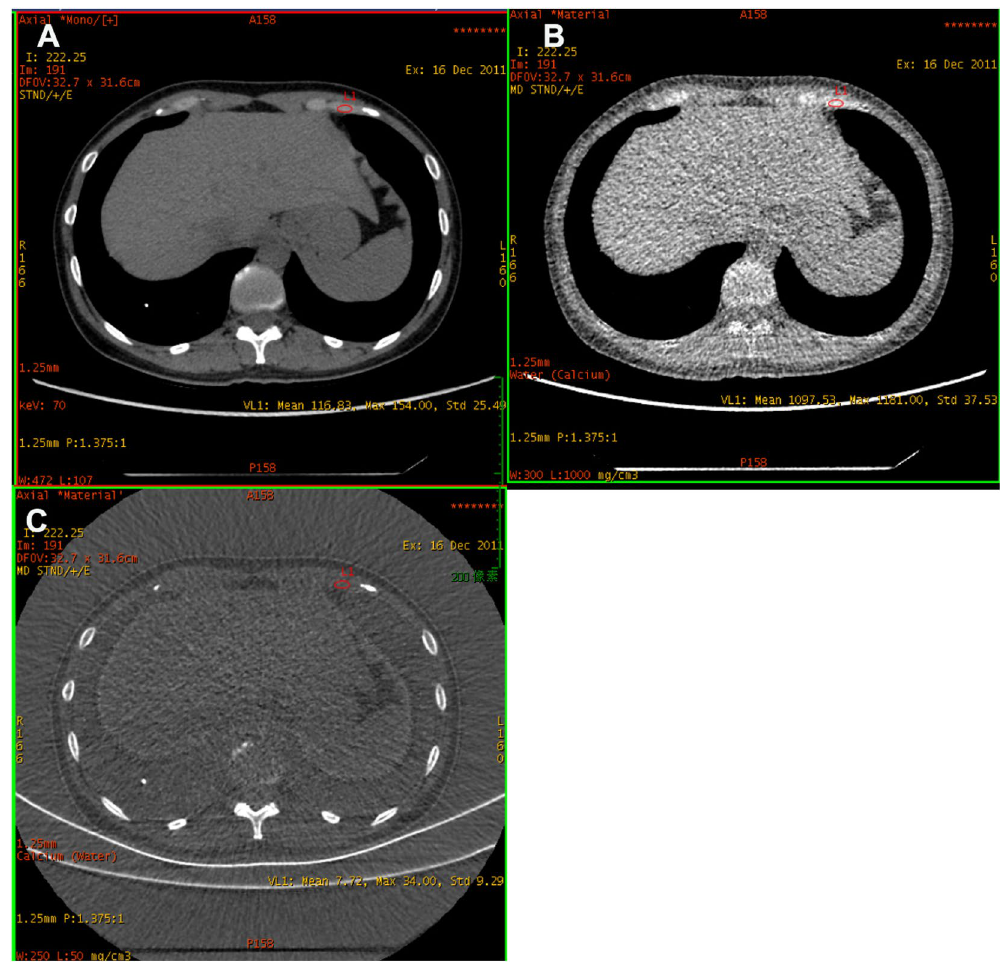
Figure 6. The evaluation of costal cartilage using DECT. ( A ) The CT value of costal cartilage. ( B ) The water concentration of costal cartilage. ( C ) The calcium concentration of costal